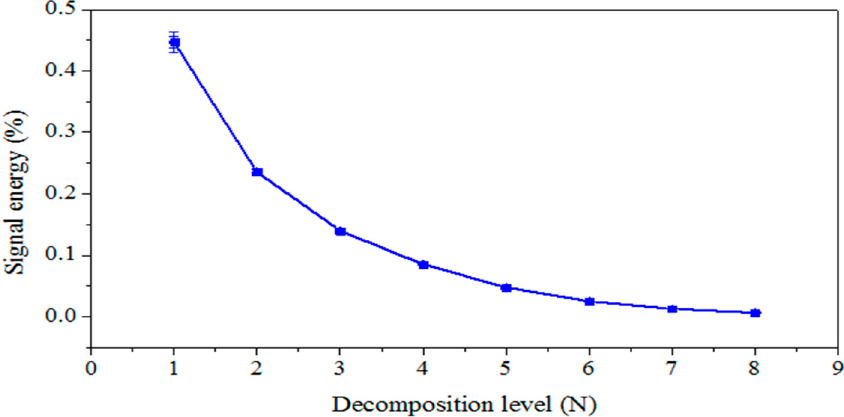
Figure 7. Signal energies distribution of detail components in the VIS.